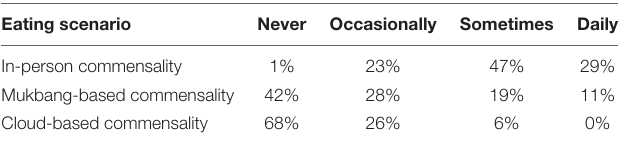
FIGURE 3 | Mean scores of food ratings. The error bars show the standard errors of the means. ∗ p < 0.05, ∗∗ p < 0.01, and ∗∗∗ p <